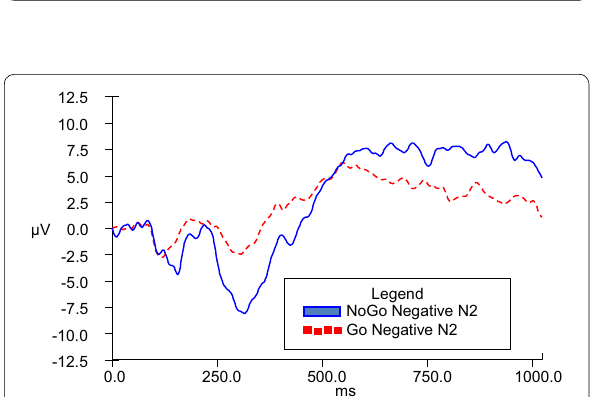
Fig. 8 Go and NoGo N2 ERP grand averages for 910-ms negative condition at electrode